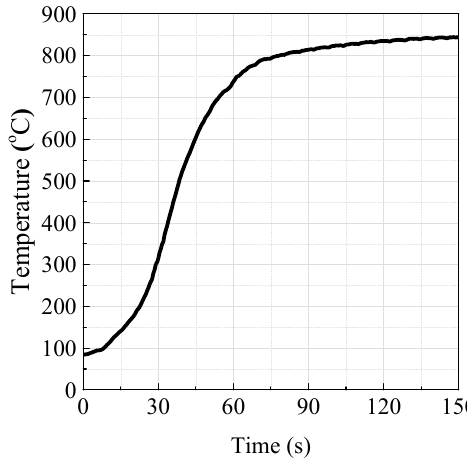
Figure 3. The heating curve of crucible in LC-TGA (5 standard liters per minute at 1 atm, 0 °C (SLM)).